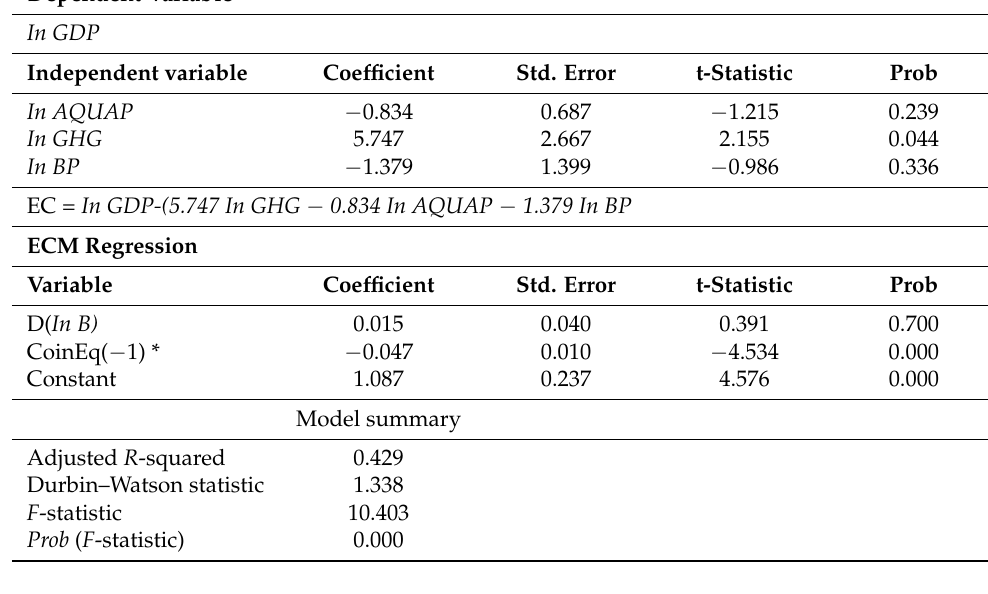
Table 5. Pairwise Granger causality test.